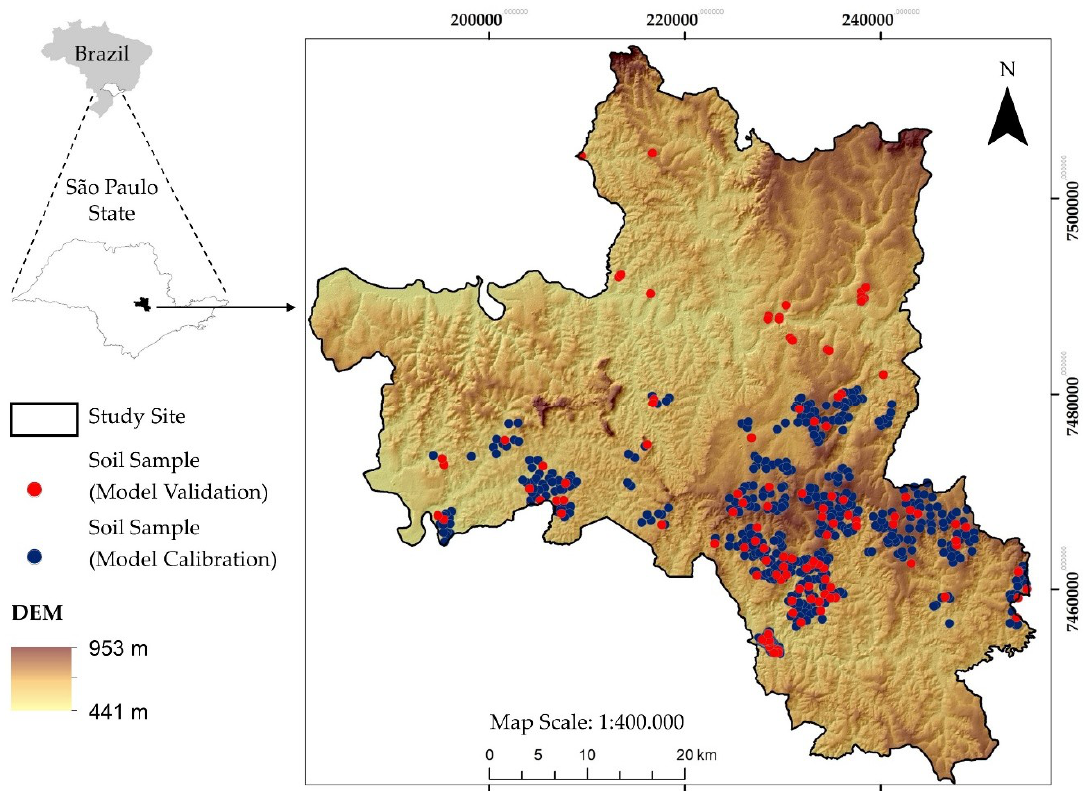
Figure 2. The study area showing the geographic distribution of soil samples for laboratory measurement in São Paulo State, Brazil.